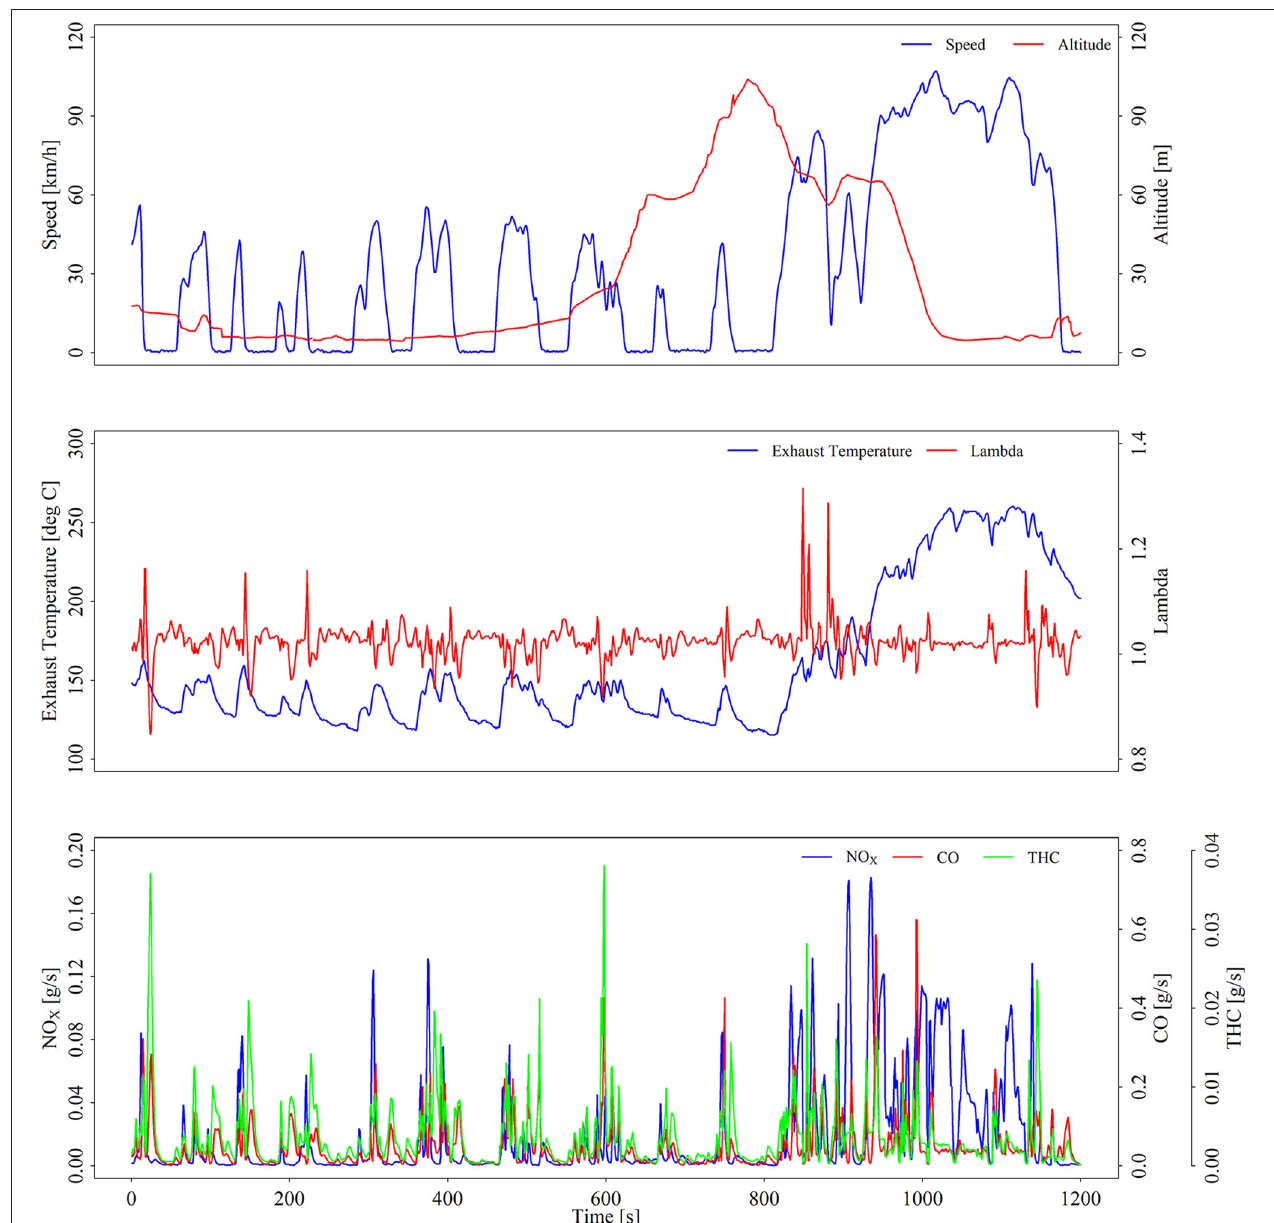
FIGURE 3 | Example of an on-road trip (pre-Euro 4O vehicle) with profiles of recorded signals. Top: speed and altitude, Middle: Exhaust gas temperature and lambda value, Bottom: NO x , CO, and THC emission mass